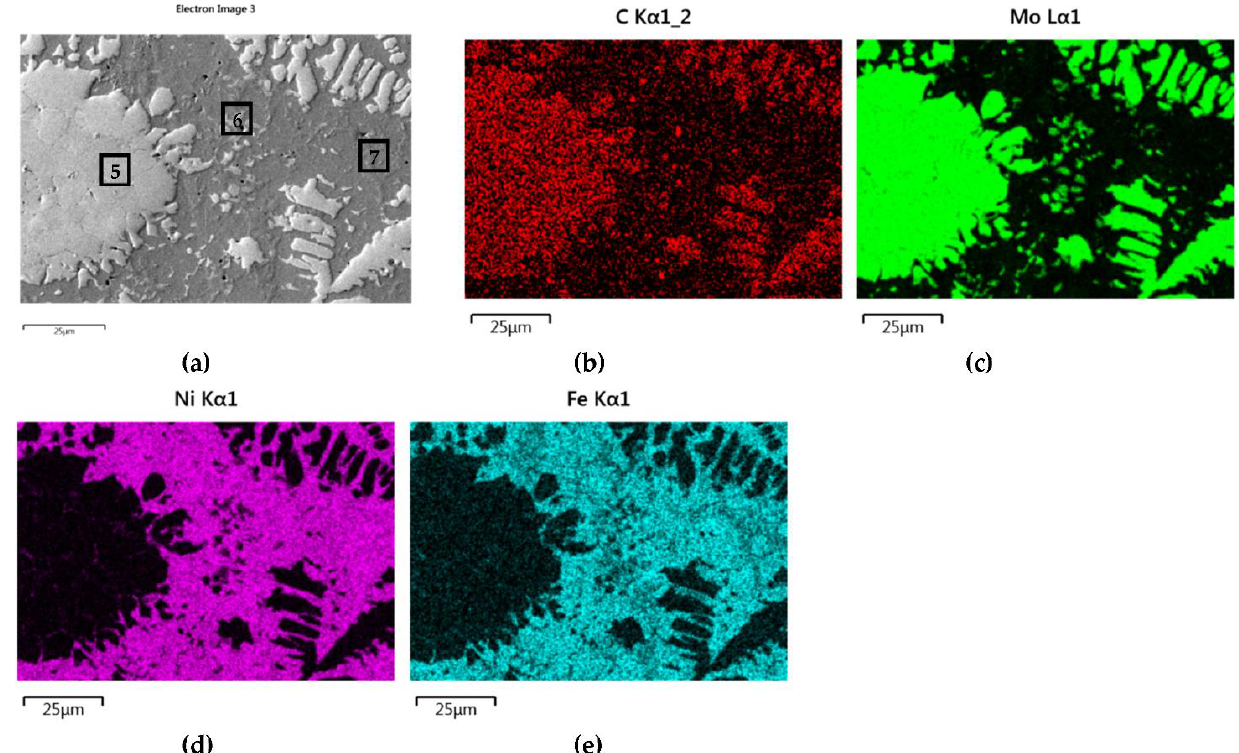
Figure 14. NiBSi – Mo 2 C layer: SEM micrograph with points of the quantitative analysis marked ( a ), and surface distribution of: C ( b ), Mo ( c ), Ni ( d ), and Fe ( e ).